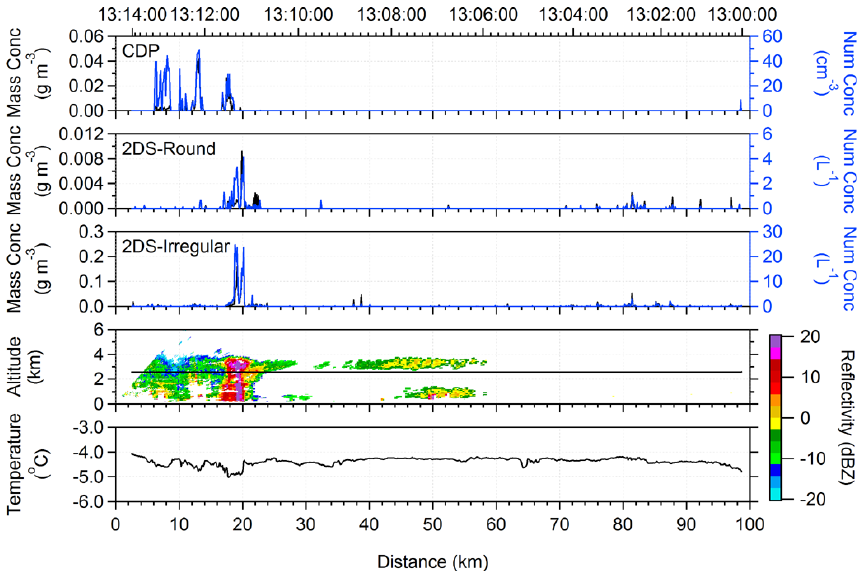
Fig. 8. Same as Fig. 5, except for run R5. The CAMRa RHI scan shown is from